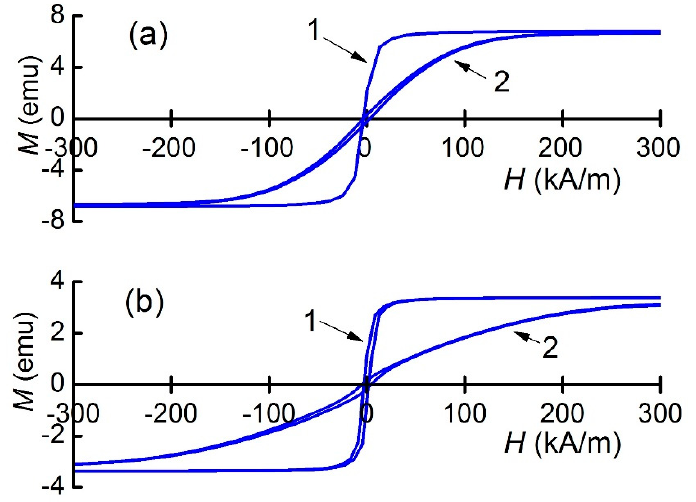
Figure 3. Magnetization curves of MFCs with the spatial period of ( a ) T 1 = 250 μ m and ( b ) T 2 = 500 μ m for the constant magnetic field H oriented along (1) and perpendicular to (2) to Ni-wires.